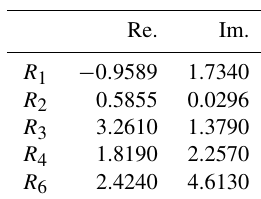
Table 2. The real part (Re.) and the imaginary part (Im.) of the selected result.